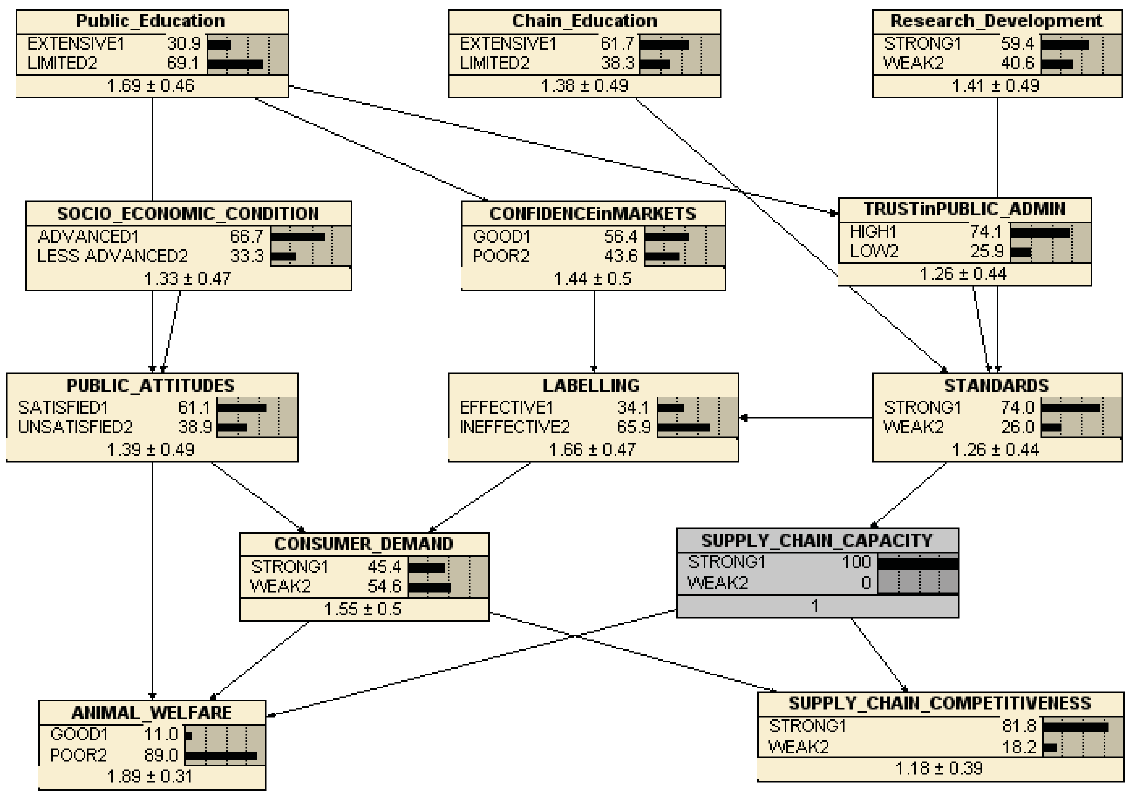
Figure 7. Belief Network consequences of improved supply chain capacity.